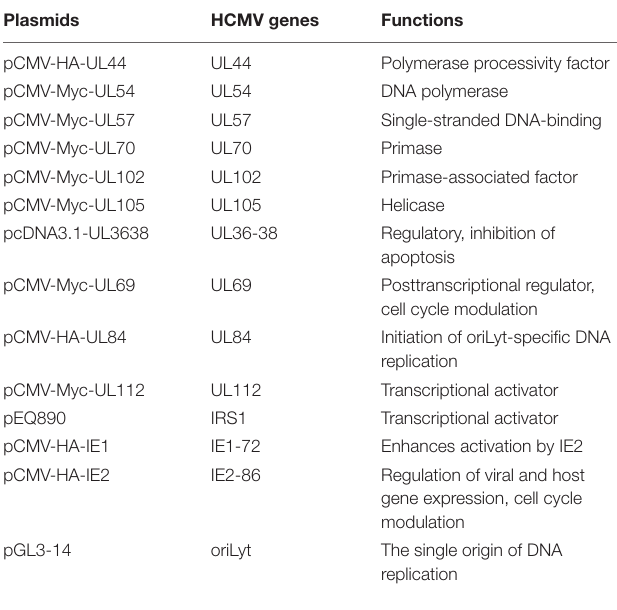
TABLE 2 | HCMV DNA replication-related genes and plasmids used in the study. Plasmids HCMV genes